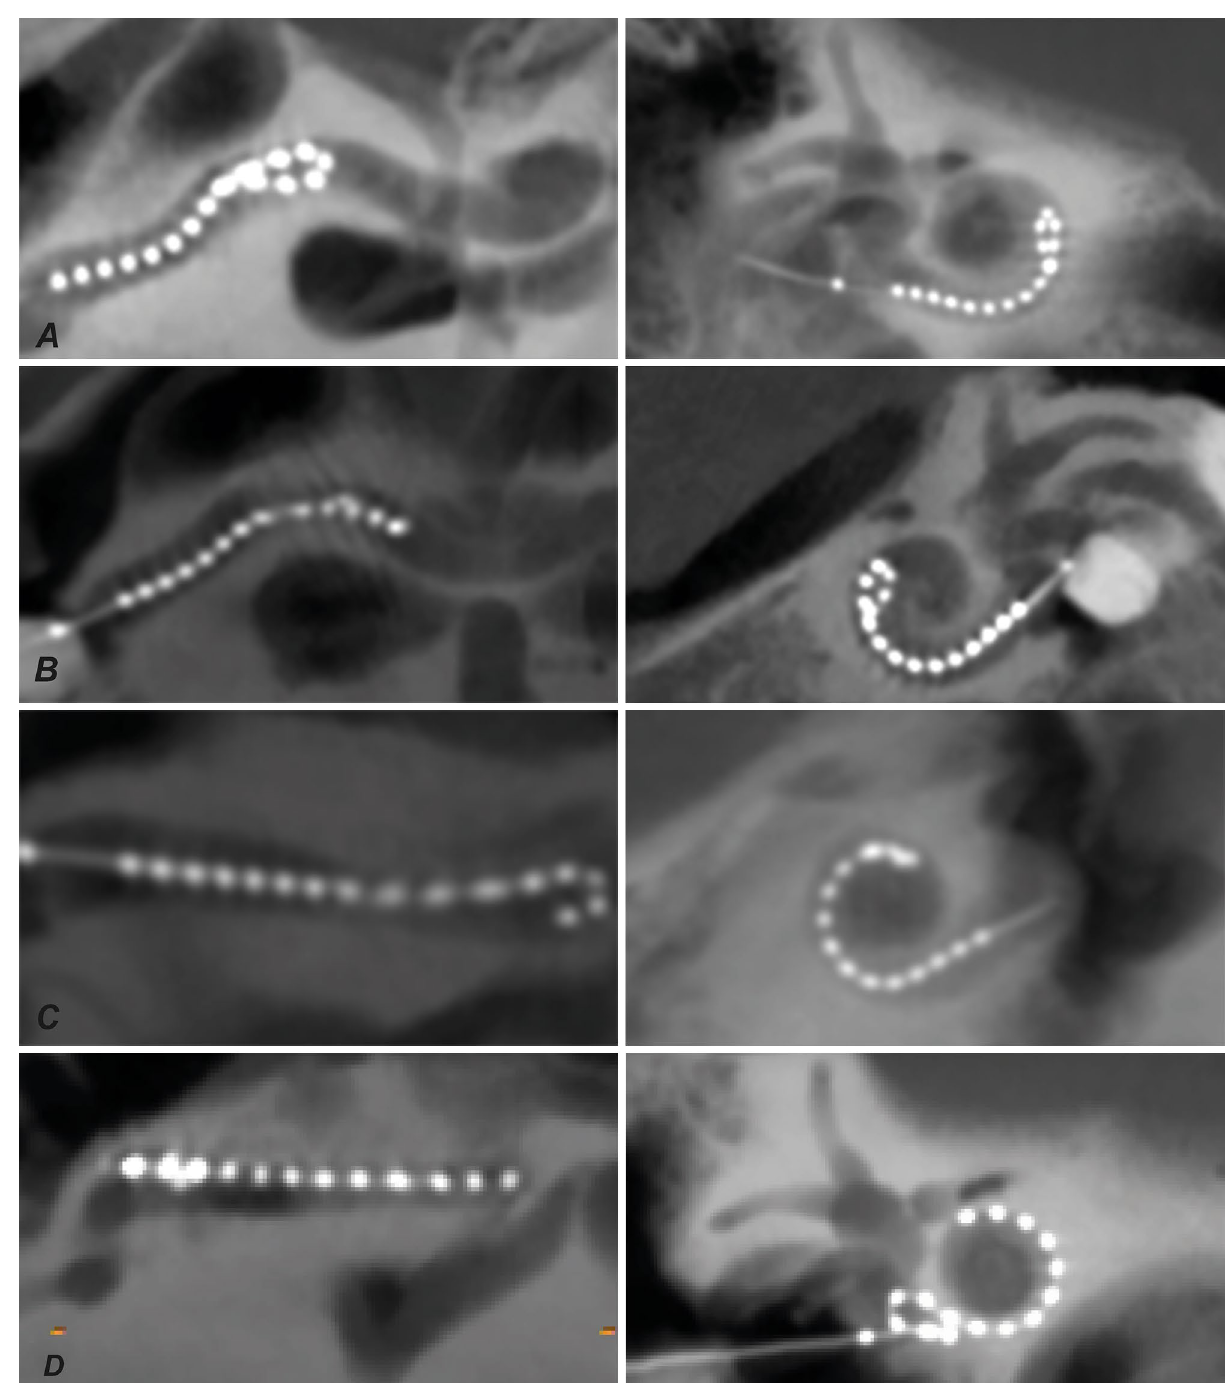
Figure 7. Four fold-overs were observed, depicted on the left with uncoiled cochlear reconstructions and on the right with conventional reconstructions. In ( A–C ) a PM array was used. Two tip fold-overs occurred at similar position (see A,B ), approximately at insertion depth of 180°, while the other tip fold-over occurred deeper at around 270° ( C ). Finally, in ( D ) a case with a basal fold-over had occurred using the LW array. In both reconstruction techniques the fold-overs were clearly seen. PM perimodiolar, LW lateral